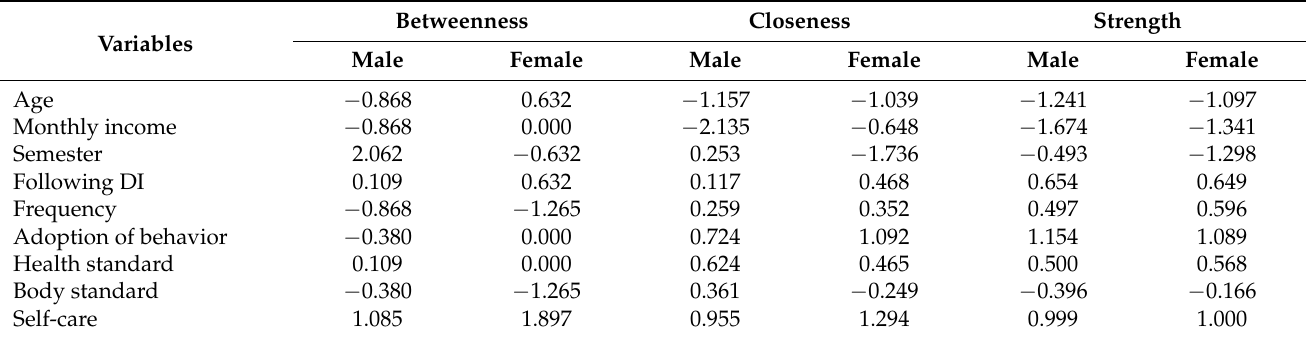
Table 3. Centrality measures of the networks.